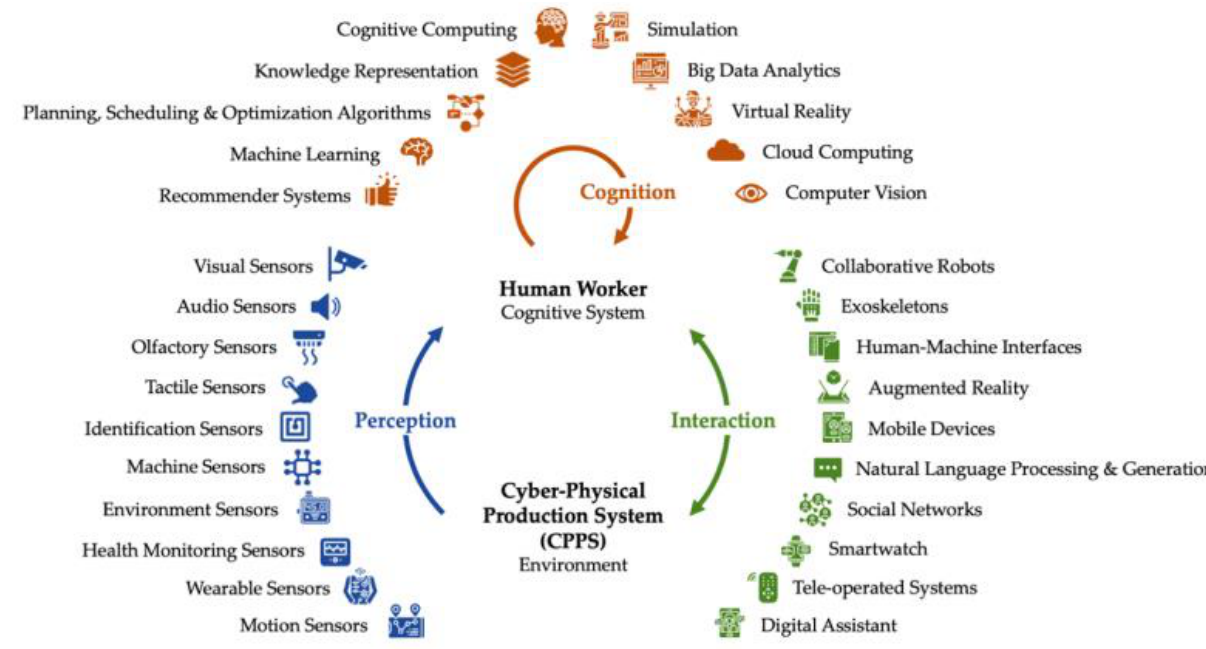
Figure 5. Human-machine interactions (symbiosis) of I5.0: Technologies increase people’s capabilities and skills due to a cognitive-type process [44].